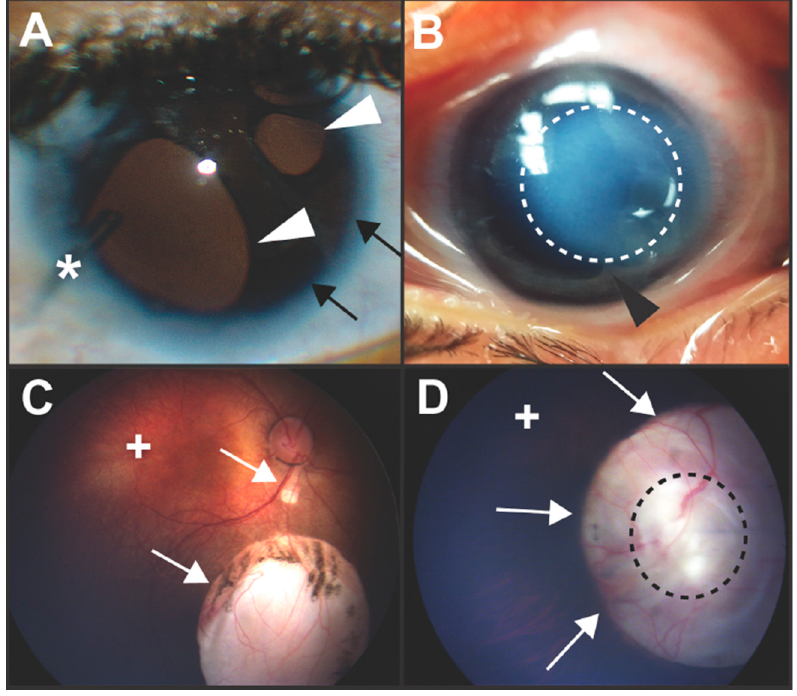
Figure 1. Clinical images of congenital ocular anomalies. ( A ) Axenfeld–Rieger syndrome is characterized by Rieger Anomaly (iris hypoplasia resulting in pseudopolycoria and corectopia (white arrowheads)) and Axenfeld Anomaly (anteriorization of Schwalbe’s line of the cornea (posterior embryotoxon, black arrows) with iris adhesions). These defects are due to abnormal migration and differentiation of neural crest cells into the anterior segment of the eye. Over 50% of individuals with Axenfeld–Rieger syndrome develop glaucoma which often requires surgery such as placement of a glaucoma drainage device (asterisk). ( B ) In Peters anomaly, there is a circumscribed central corneal opacification (outlined by dotted white line) with iris-corneal adhesions (black arrowhead). These anomalies are due to abnormal separation of the lens vesicle from the surface ectoderm resulting in absence of Descemet’s membrane and disruption of neural crest cell migration into the anterior segment. ( C ) and ( D ) Colobomas are due to incomplete closure of the ocular fissure and can affect the iris, zonules, retina, choroid, and optic nerve. Chorioretinal colobomas are inferior to the optic nerve and are characterized by an area that is devoid of retina and choroid ( C , white arrows). In these types of coloboma, the macula (+) which accounts for central vision, is typically not affected. Optic nerve colobomas ( D , white arrows) can cause severe vision loss especially if the entire optic nerve (outlined by black dotted line) is involved. Although the macula (+) may not be affected, the loss of the ganglion cell axons that comprise the optic nerve limits vision.